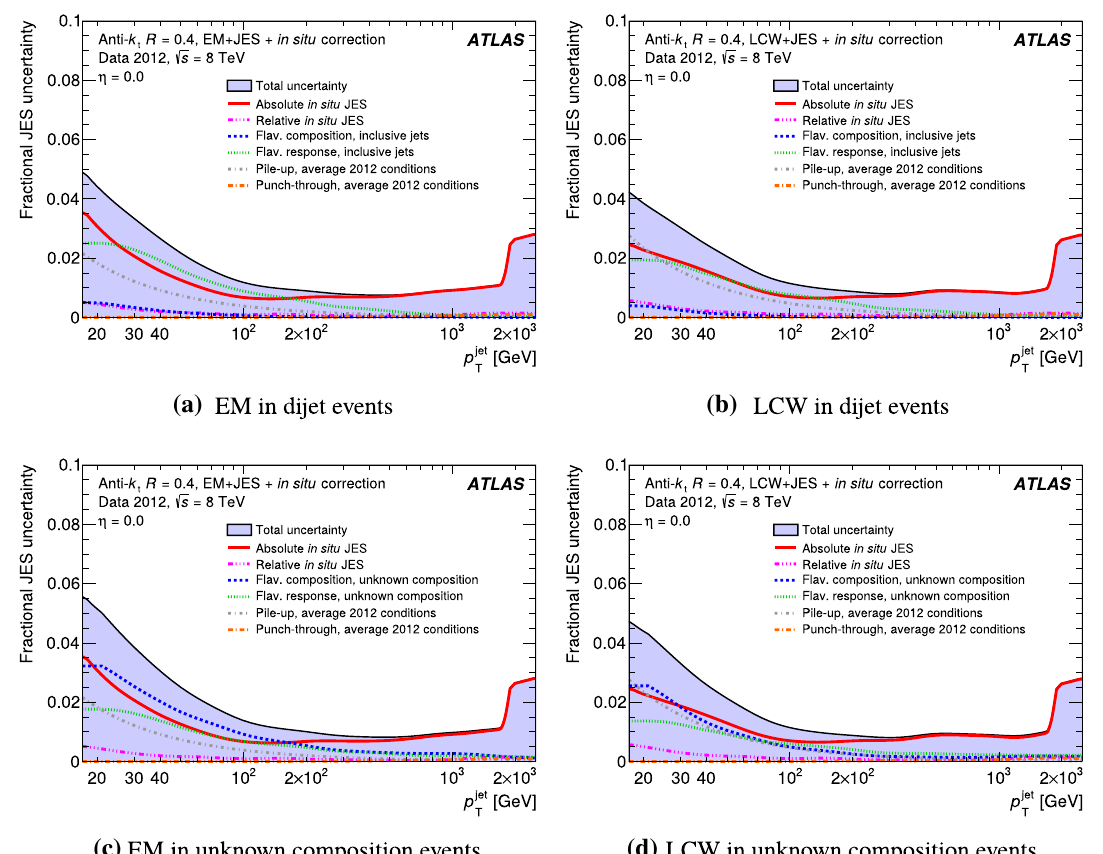
Fig. 41 The total jet energy scale uncertainty as a function of p T for central jets. Two flavour compositions are shown, one for dijet events, where the quark/gluon composition is taken from MC simulations and an associated uncertainty from generator comparisons, and one for an unknown flavour composition (assuming 50:50 quark:gluon jets with a 100% uncertainty). “Absolute in situ JES” refers to the uncertainty aris-